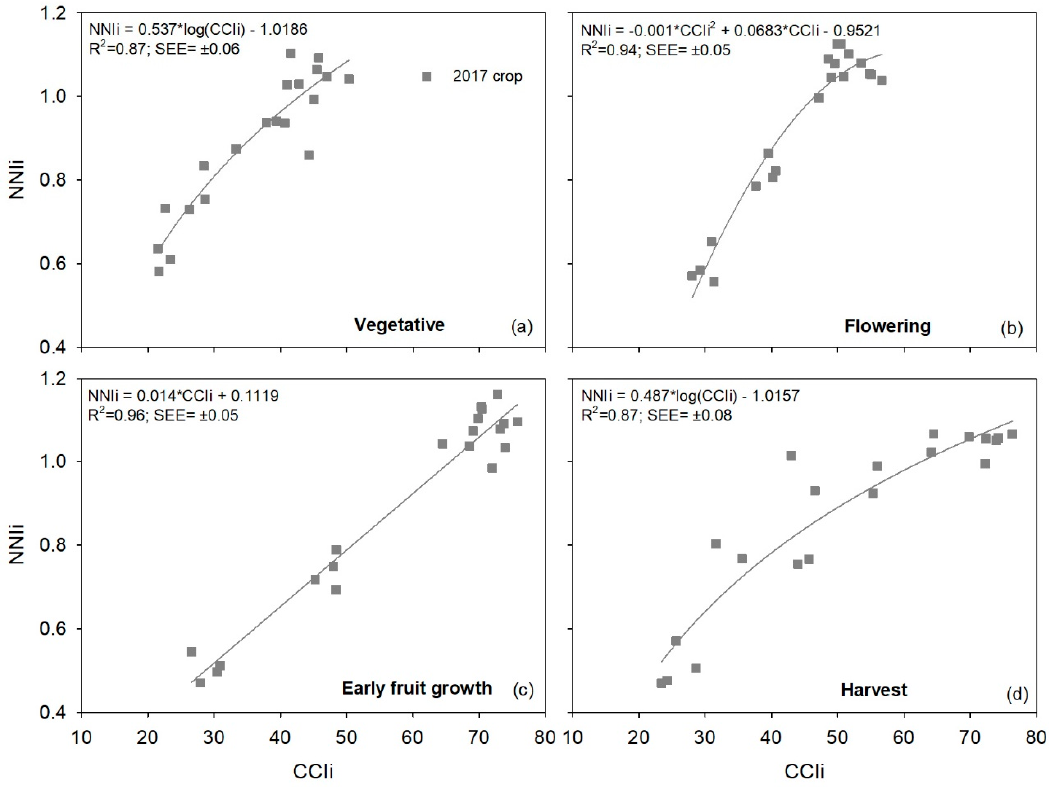
Figure 5. Relationships between integrated chlorophyll content index ( CCIi ) values and the integrated crop nitrogen nutrition index ( NNIi ) for each phenological stage in a sweet pepper ( Capsicum annuum ) crop in 2017. The crop was subjected to five di ff erent N treatments with four repetitions. Results of regression are in Table 8.